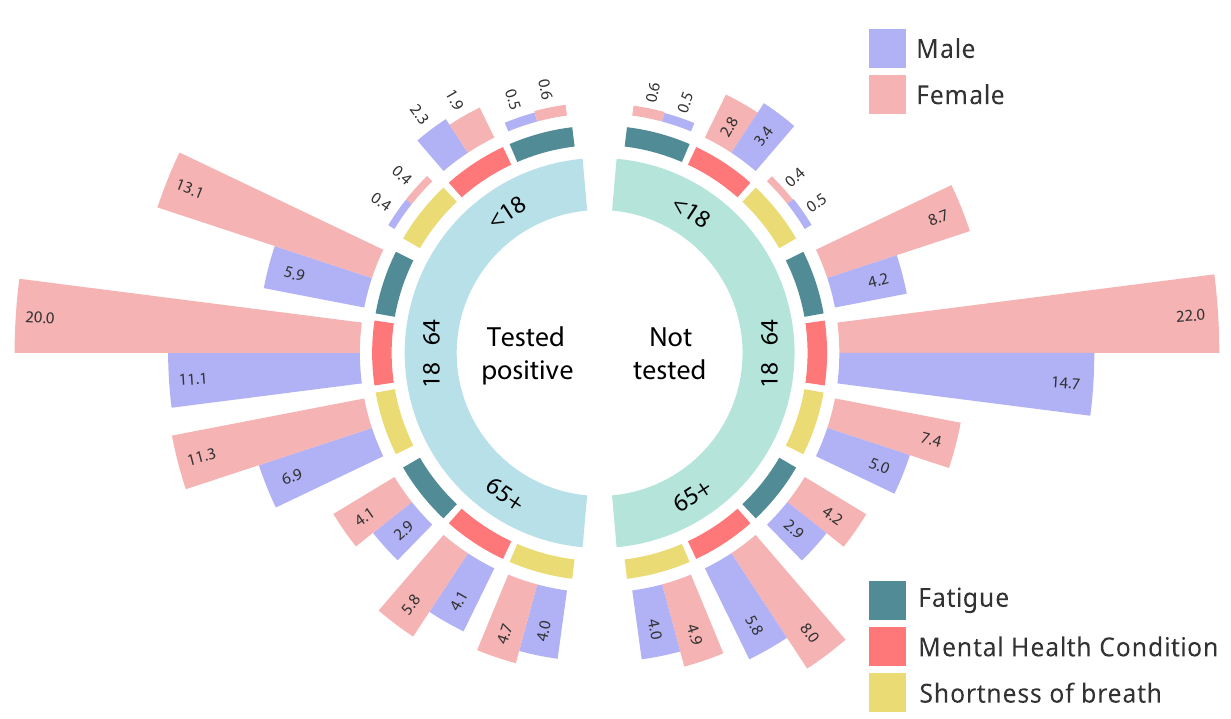
FIGURE2 Analysis of long COVID symptoms in patients with positive or negative COVID-19 PCR test. Relative frequency of symptoms in individuals with a positive COVID-19 PCR test (left) as compared to individuals with a negative test. Elaborated on basis of LC symptoms registered by the National COVID Cohort Collaborative (N3C) initiative. Data acquired from